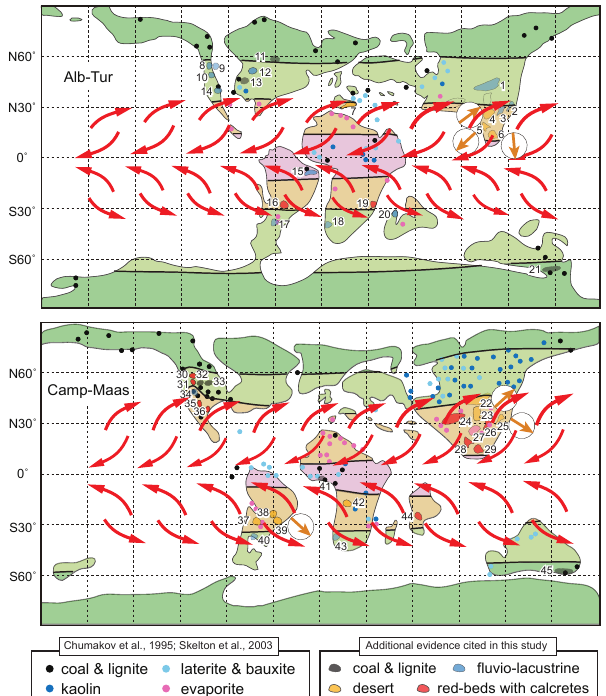
Fig. 3. Global distribution of climate-indicative sediments (e.g. coals, laterite, and desert deposits) and the inferred latitudi- nal distribution of paleoclimatic zones during the mid-Cretaceous (Albian–Turonian) and late Cretaceous (Campanian–Maastrichtian) (modified after, Chumakov et al., 1995; Skelton et al., 2003; and additional evidences cited in this study; localities listed by number in Supplement Table S2). Pink, yellow, light green and dark green zones represent the distribution of tropical humid, subtropical arid, mid-latitude warm humid, and high-latitude temperate zones, re-